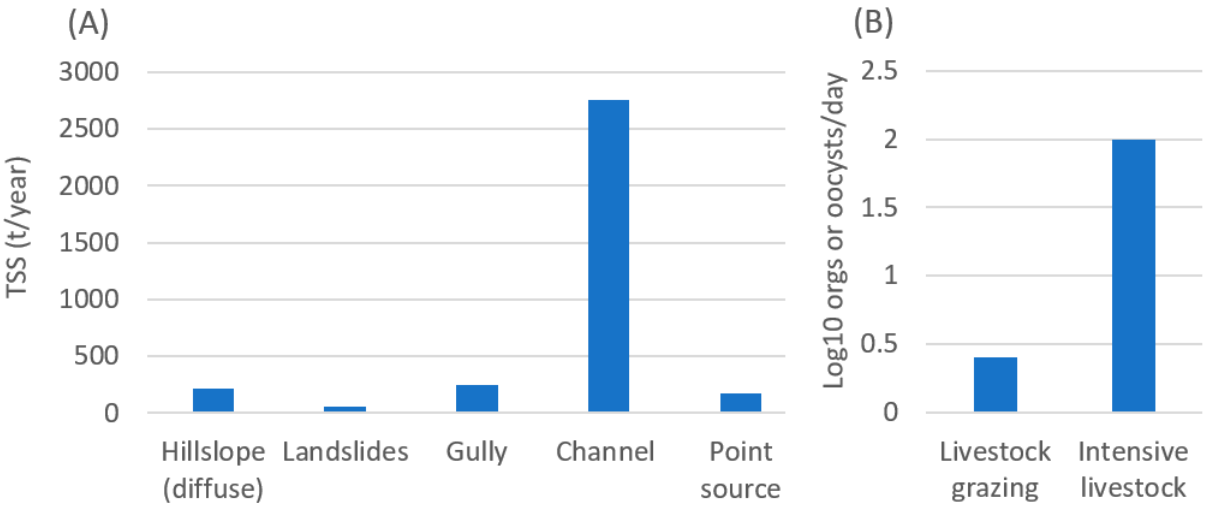
Figure 6. Reduction in ( A ) TSS and ( B ) pathogen loads to Cedar Grove Weir based on the selected solution portfolio of interventions. Intervention log reduction values for bacteria and protozoa are the same.